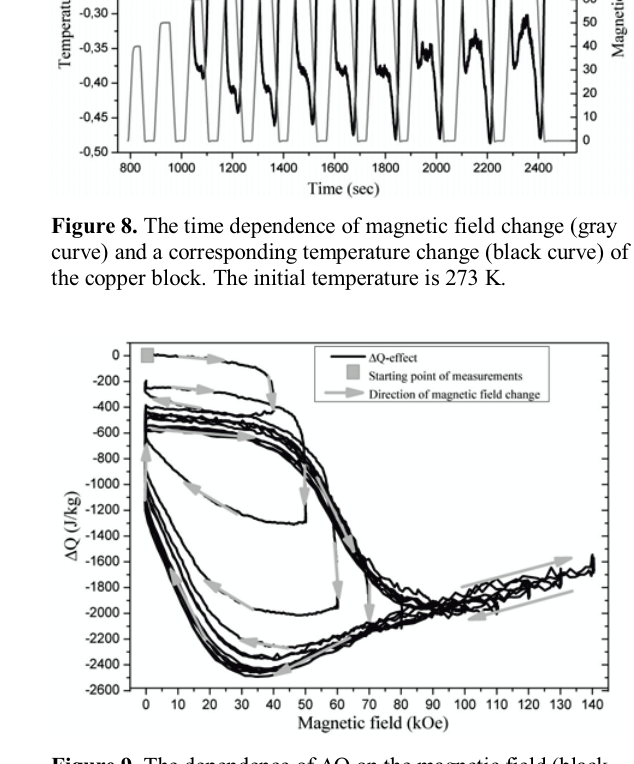
Figure 9. The dependence of ∆Q on the magnetic field (black curve). The gray arrows show the direction of the magnetic field change. Gray square shows starting point of the measurements. The initial temperature is 273